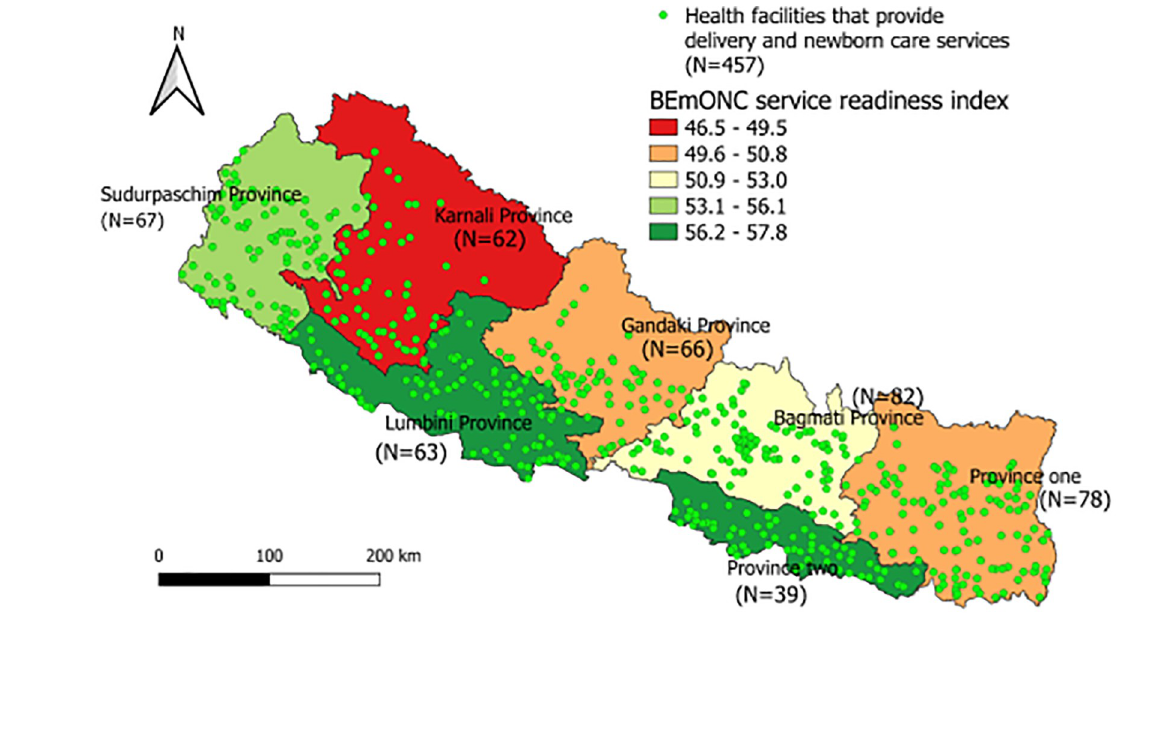
Fig 1. BEmONC service readiness index in health facilities by